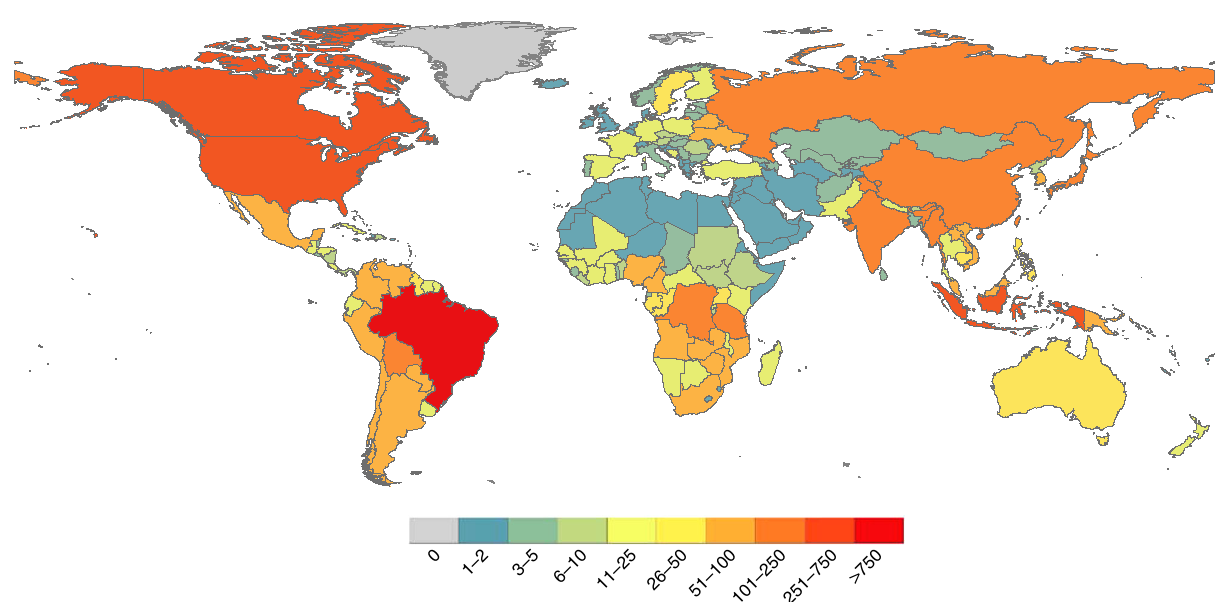
Fig. 3 Projected annual GHG mitigation by country, across all forest sector abatement activities in 2055. Mitigation is measured in MtCO 2 yr − 1 and is presented on a scale from grey (no mitigation potential) to red (largest mitigation